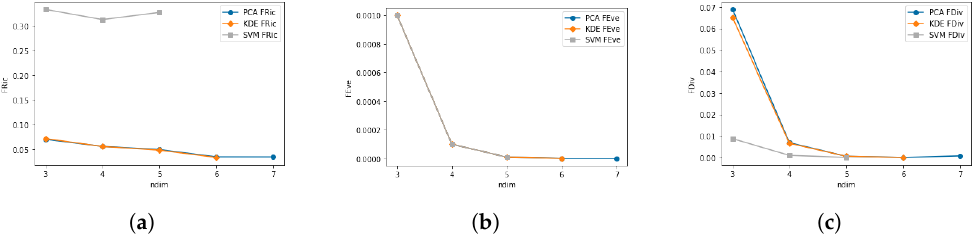
Figure 4. Chart comparing TPD outputs between KDE, KDE+PCA, and SVM in relation to the number of dimensions. ( a ) Functional richness. ( b ) Functional evenness. ( c ) Functional